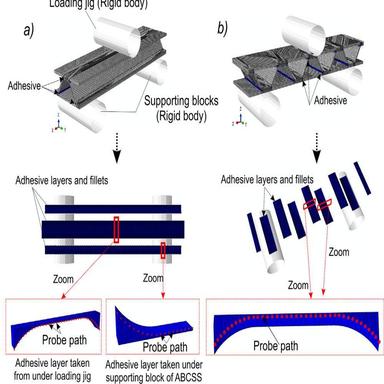
Adhesive layer locations in the ABCSS chosen for stress state analysis in a) longitudinal; b) transverse loading directions.